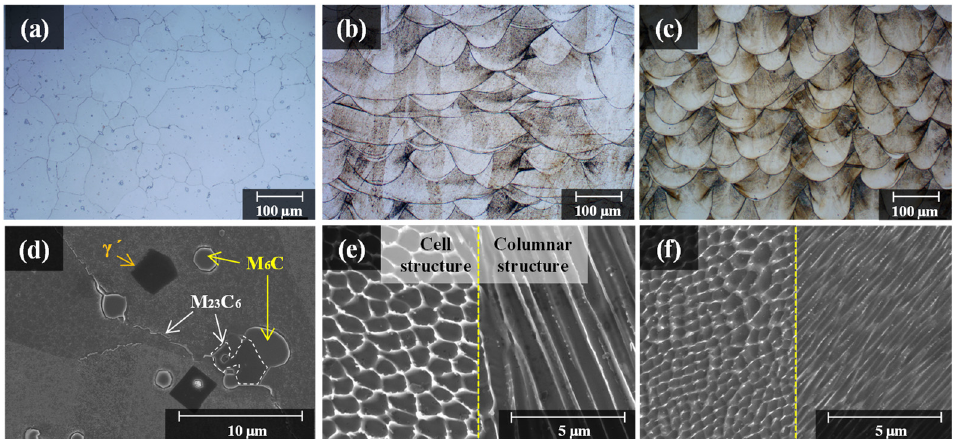
Figure 6. OM micrographs of the ( a ) cast Hastelloy X specimens and fabricated Hastelloy X specimens with different process parameters; ( b ) Powder I as-built specimen; ( c ) Powder II as-built specimen; SEM micrographs of ( d ) cast, ( e ) Powder I as-built specimen, and ( f ) Powder II as-built specimen.